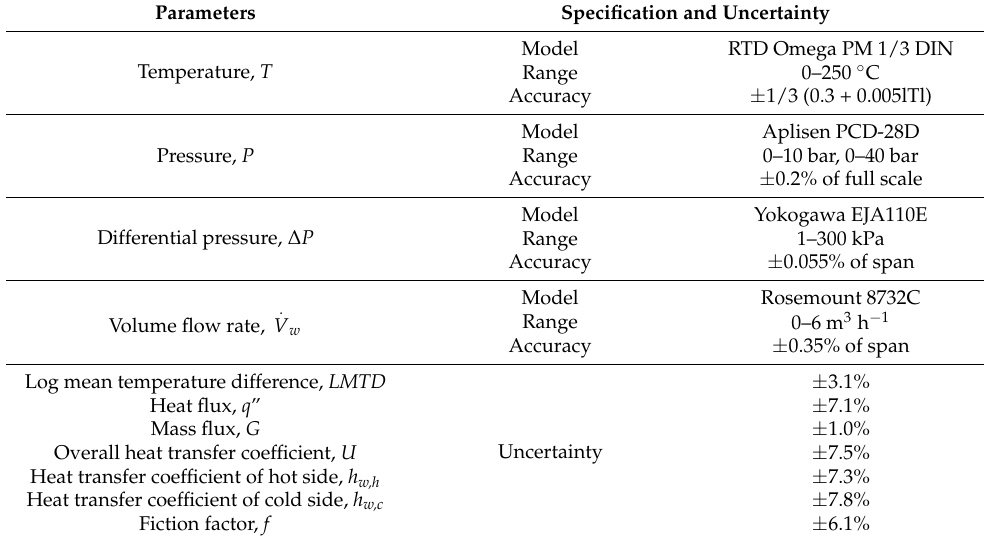
Table 3. Systematic errors of sensors and relative uncertainties of